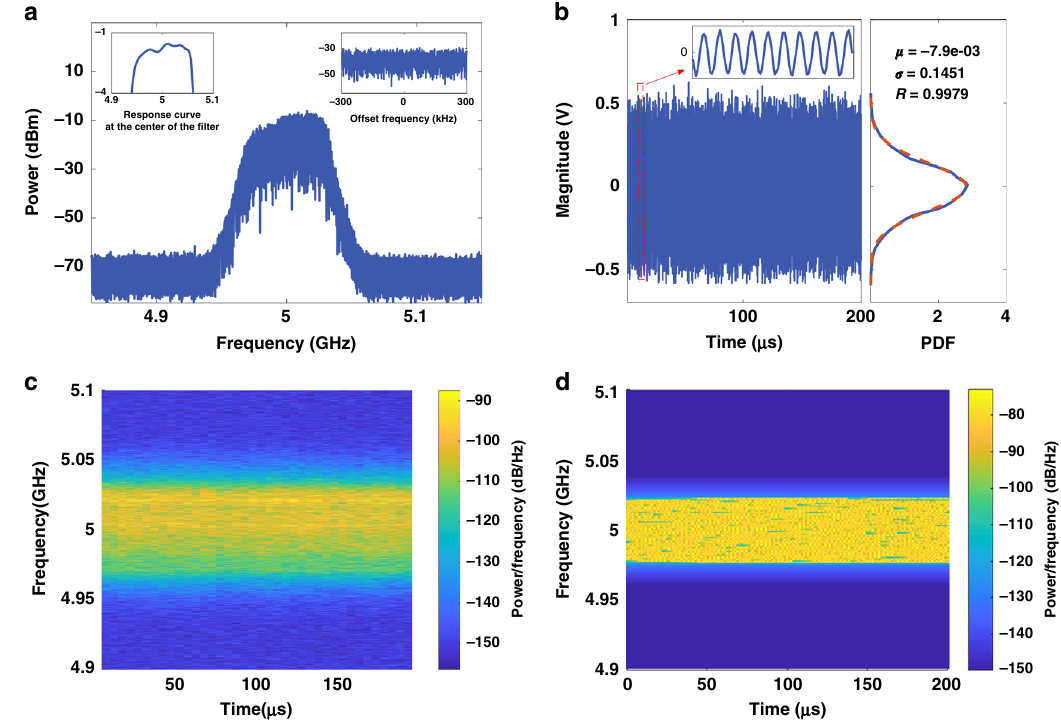
Fig. 2 Experimental results. A radiofrequency fi lter centered at 5 GHz with a 3-dB bandwidth of 60 MHz is used in the cavity. a Spectrum results of signals oscillating in the OEO. All frequencies in the passband oscillate in the OEO without discrete mode interval. The inset on the right shows a section of the spectrum with a span of 600 kHz, which clearly shows that there are no longitudinal modes under different spans. The inset on the left displays the response curve near the center frequency of the fi lter. b Temporal waveform and the probability density function of the signal. The inset is a section of the waveform. The waveform approximates a sinusoidal signal with a period that varies slightly around 0.2 ns. The right panel displays the Gaussian probability density function of the random signal as shown by the blue solid line. The orange dotted line shows the Gaussian distribution. The mathematical expectation μ is − 7.9 × 10 − 3 , and the standard deviation σ is 0.1451. The correlation coef fi cient R is 0.9979. c Real-time frequency distribution of the temporal waveform. The temporal waveform is a superposition of all oscillation frequencies in the passband rather than a periodic single-frequency signal. All the frequencies contained in the passband of the radiofrequency fi lter oscillate in OEO at the same time. For each couple of adjacent time windows, the power of a particular frequency changes randomly, and within a given time window, the power varies at different frequencies. d Simulation result of the frequency